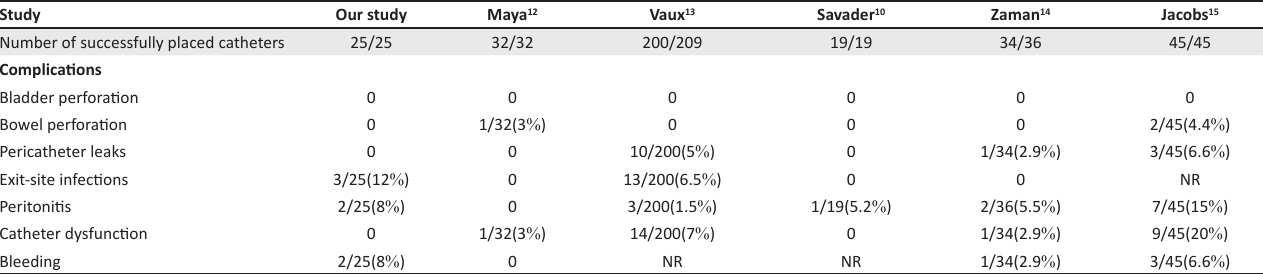
TABLE 4: Comparison of our early complications with similar published studies.